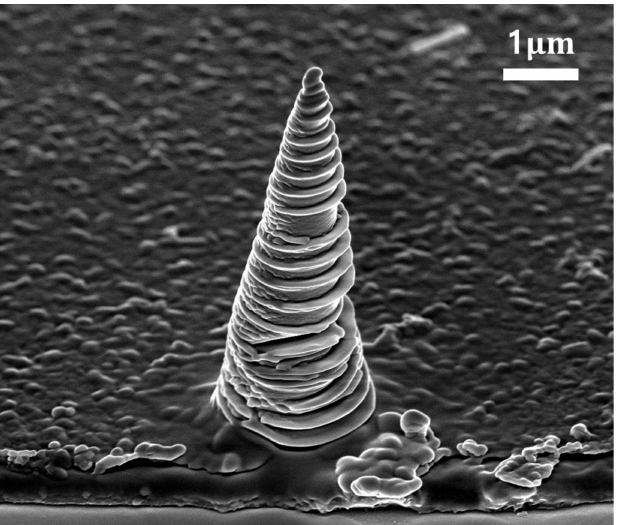
Figure 4. Electron micrograph of the Pt-tip produced via focused ion beam induced deposition